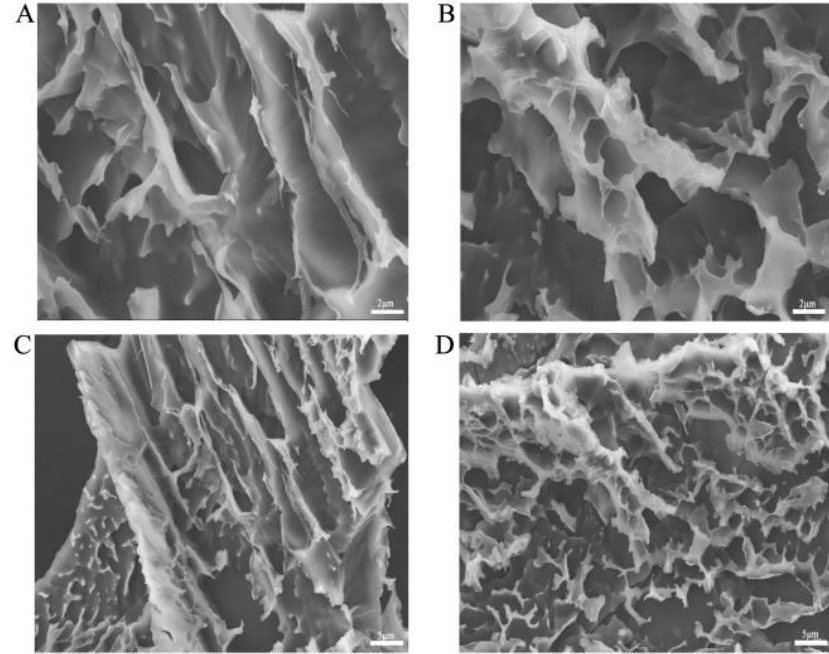
Figure 2. SEM scans of PPH hydrogels ( A – D ); scale bar: 2 µm, 5